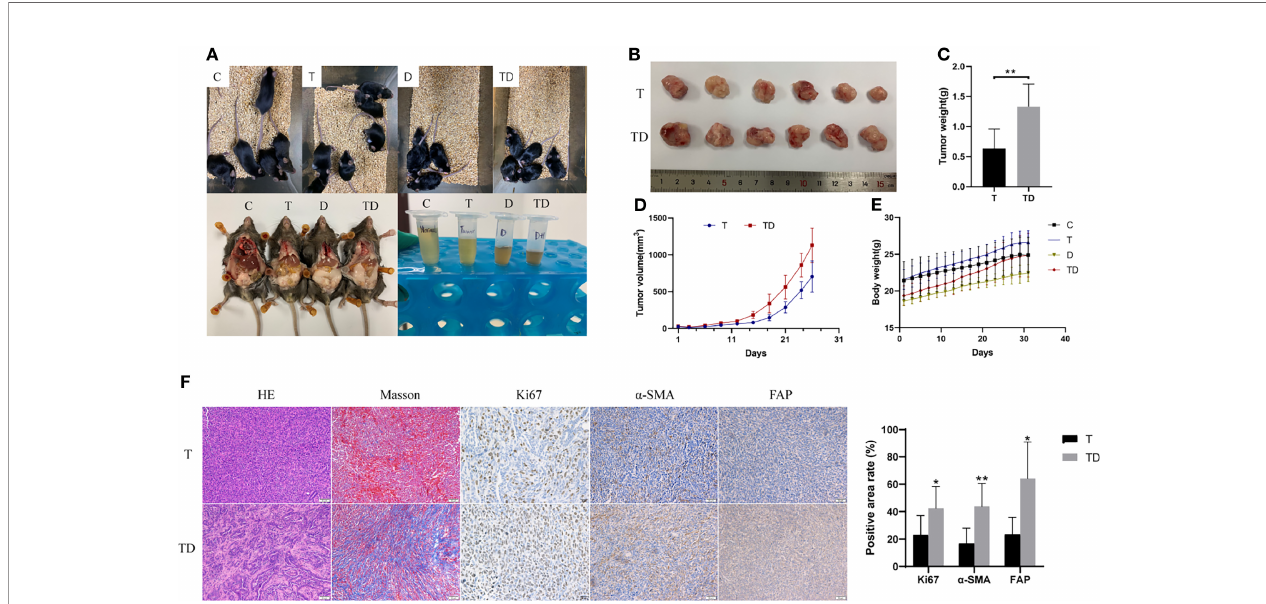
FIGURE 5 | Impact of damp-heat syndrome on the pancreatic tumor. (A) Appearance of mice in the four groups. (B) Tumors of mice with and without damp-heat syndrome. (C) Tumor weight of mice at the end of the experiment. (D) Tumor volume changes over time. (E) Body weight of mice in the four groups. (F) Histopathological observation of tumor tissue. C: control group, T: pancreatic tumor group, D: damp-heat syndrome group, TD: pancreatic tumor with damp-heat syndrome group. n = 6 in each group. *p < 0.05, **p < 0.01 compared with the T